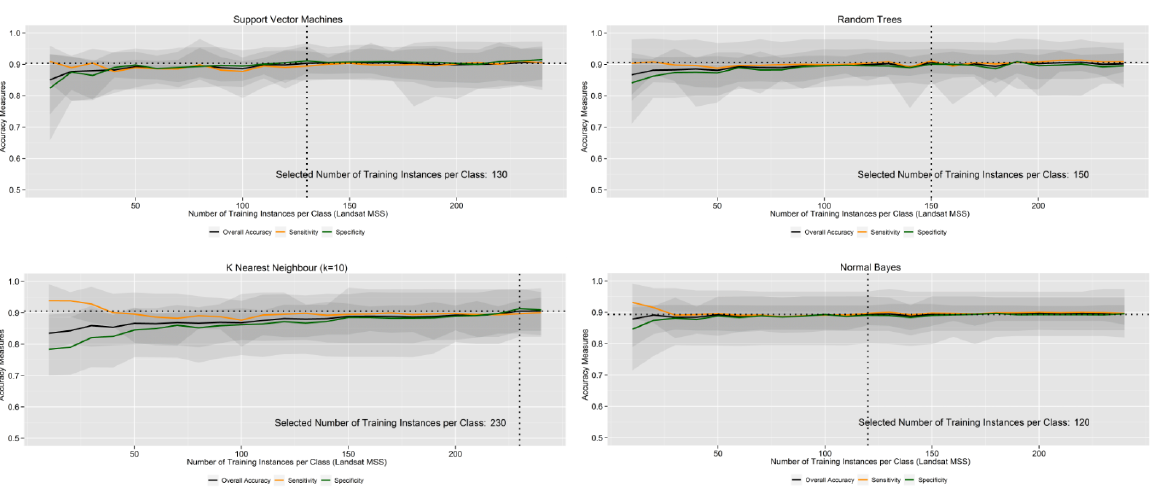
Figure 10. Influence of the training set size on the classification accuracy for MSS.